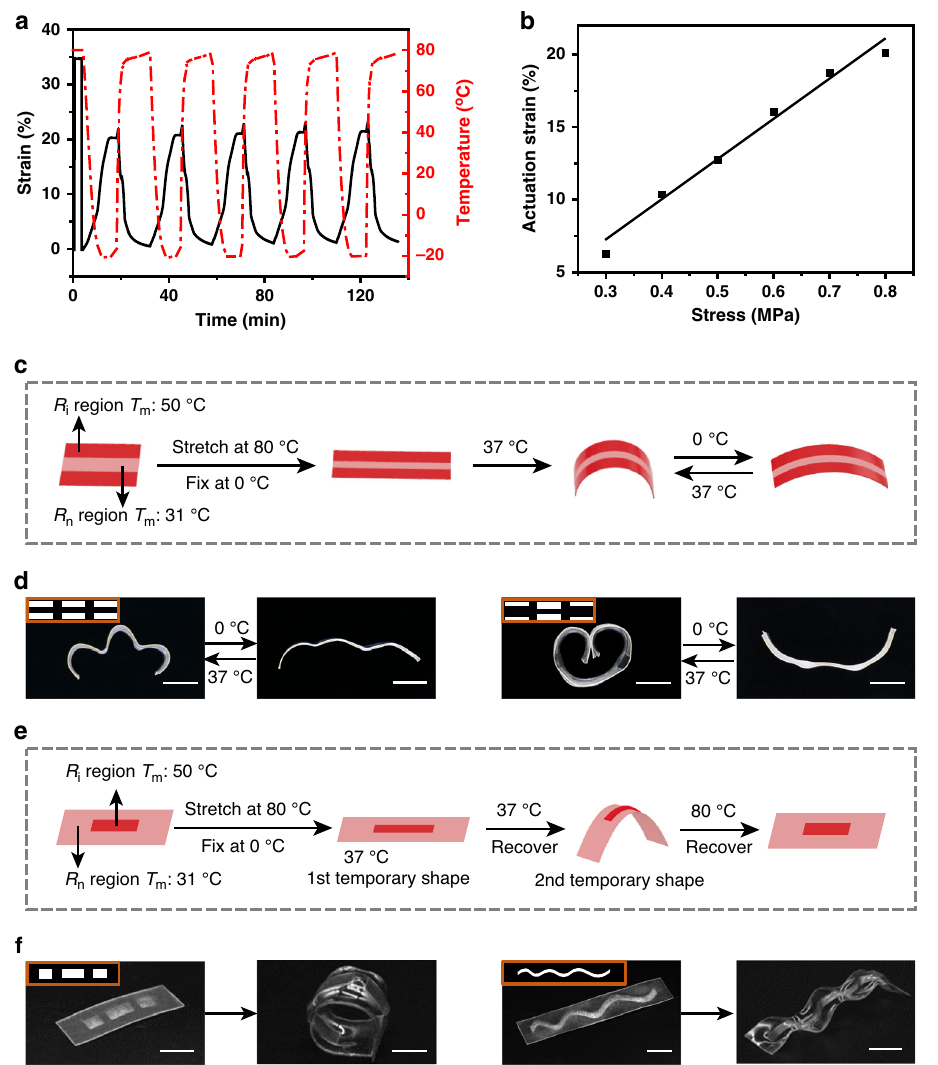
Fig. 4 Reversible and triple-shape memory performances. a Cyclic reversible actuation of a non-isomerized material under a constant stress (0.8 MPa). b The relationship between reversible strain and the external stress. c Schematic illustration of reversible shape memory process. d Reversible shape transformations obtained by patterned isomerization with the corresponding light patterns shown as the insets (light irradiation time: 300 s). e Schematic illustration of the triple-shape memory process. f The original shape and 2 nd temporary shape in the triple-shape memory cycles, with the corresponding light patterns shown as the insets (light irradiation time: 300 s). (All scale bars: 10